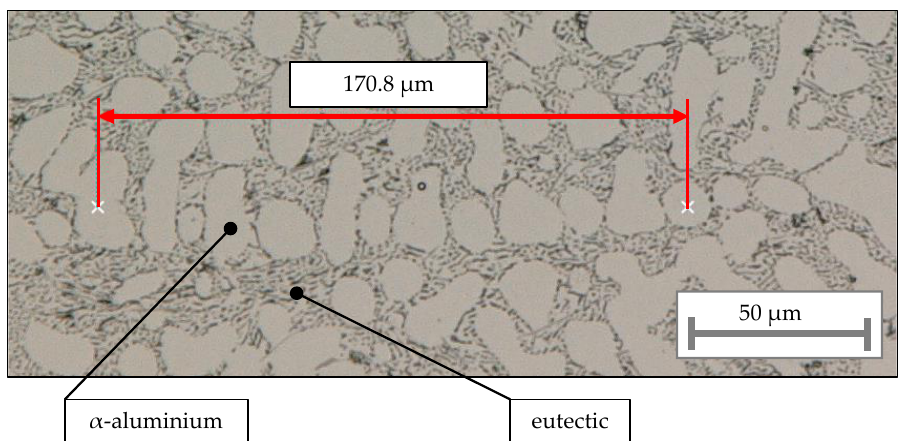
Figure 4. LOM image of AlSi9 refined with 0.048 wt % strontium, which also shows the DAS measurement.